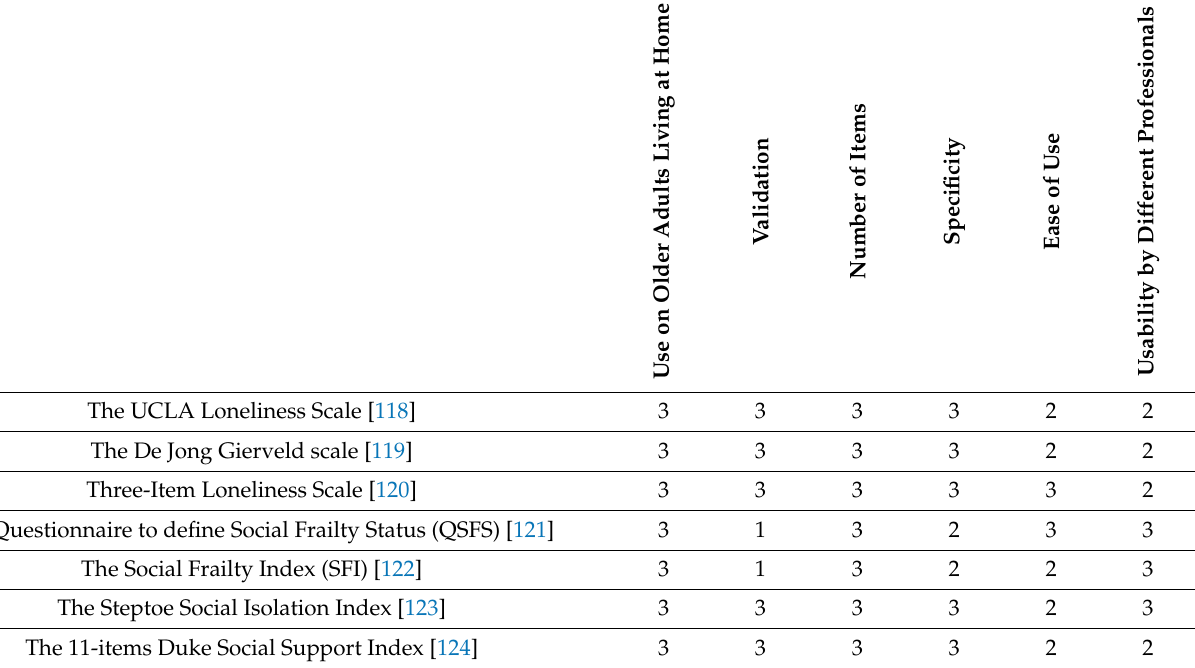
Table 7. Loneliness assessment tools